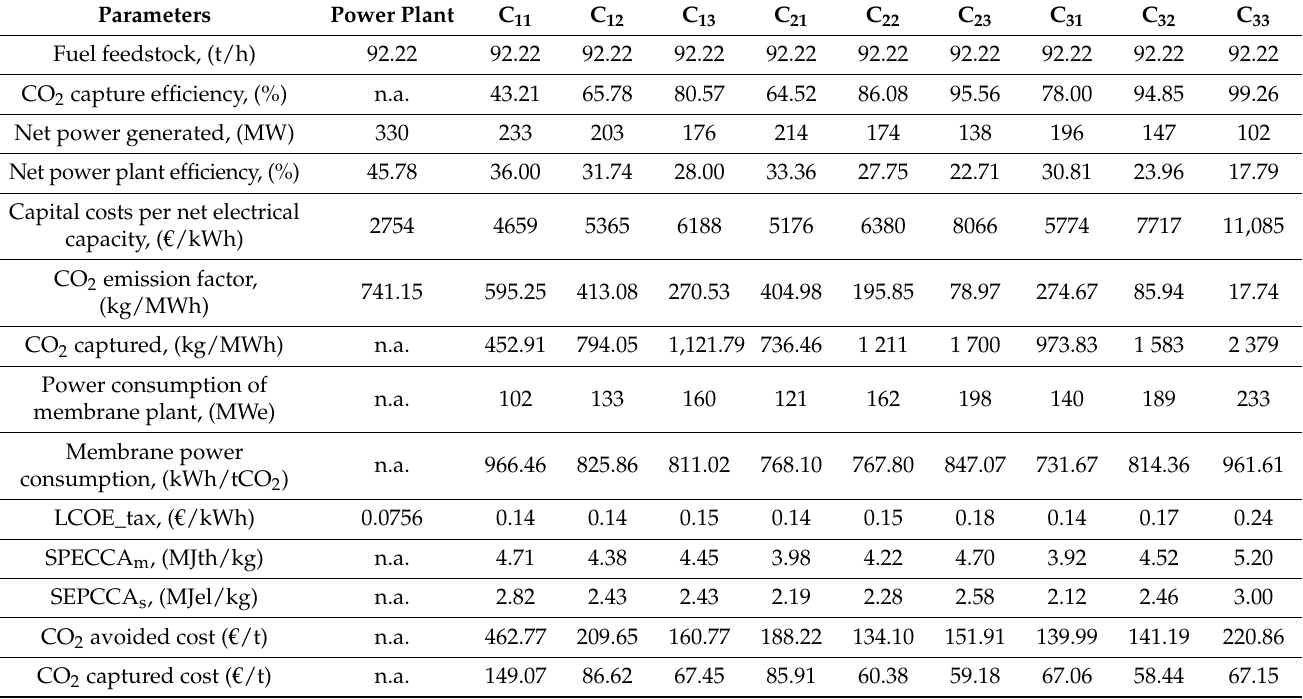
Table 16. The evaluation and economical assessment of the CFPP system with 2-stages of membrane technology.